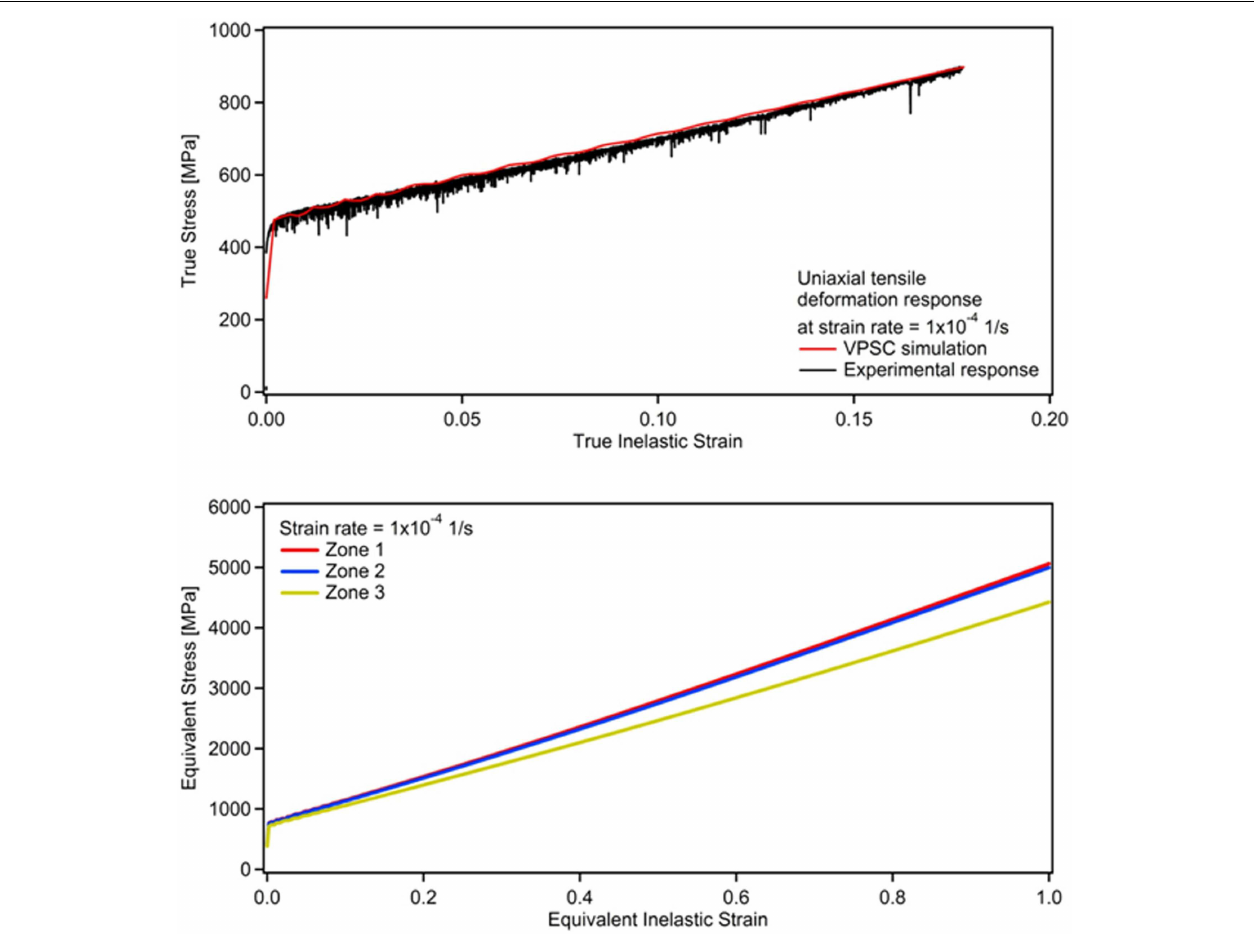
FIGURE 8 |Top:VPSC simulation of the RT experimental uniaxial tensile deformation of Hadfield steel at a strain rate of 1 × 10 − 4 1/s . Bottom: the corresponding predicted equivalent stress–strain response for each zone within the impact sample based on the distribution of stress concentration ( Figure 4 ).